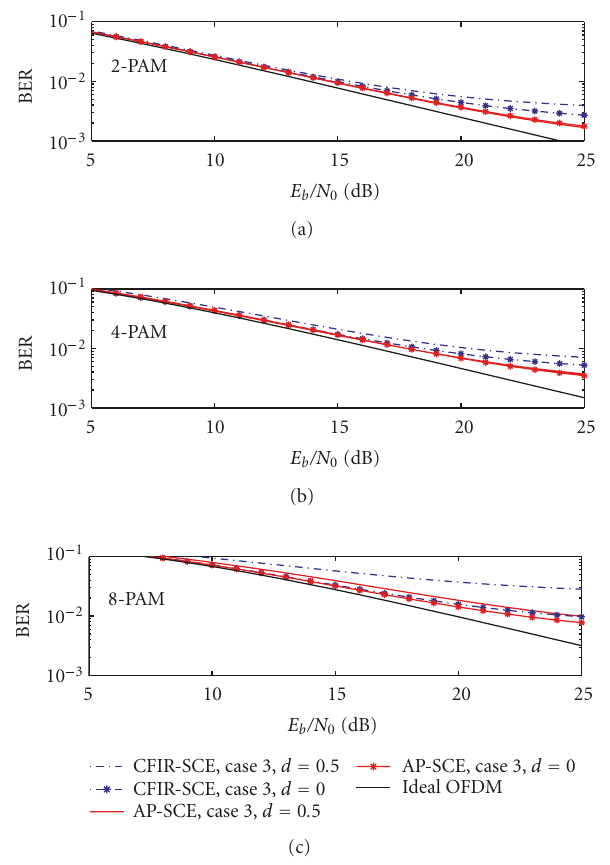
Figure 9: Semi-analytic BER in AP-SCE and CFIR-SCE. Parameter d = timing o ff set/subcarrier symbol interval.